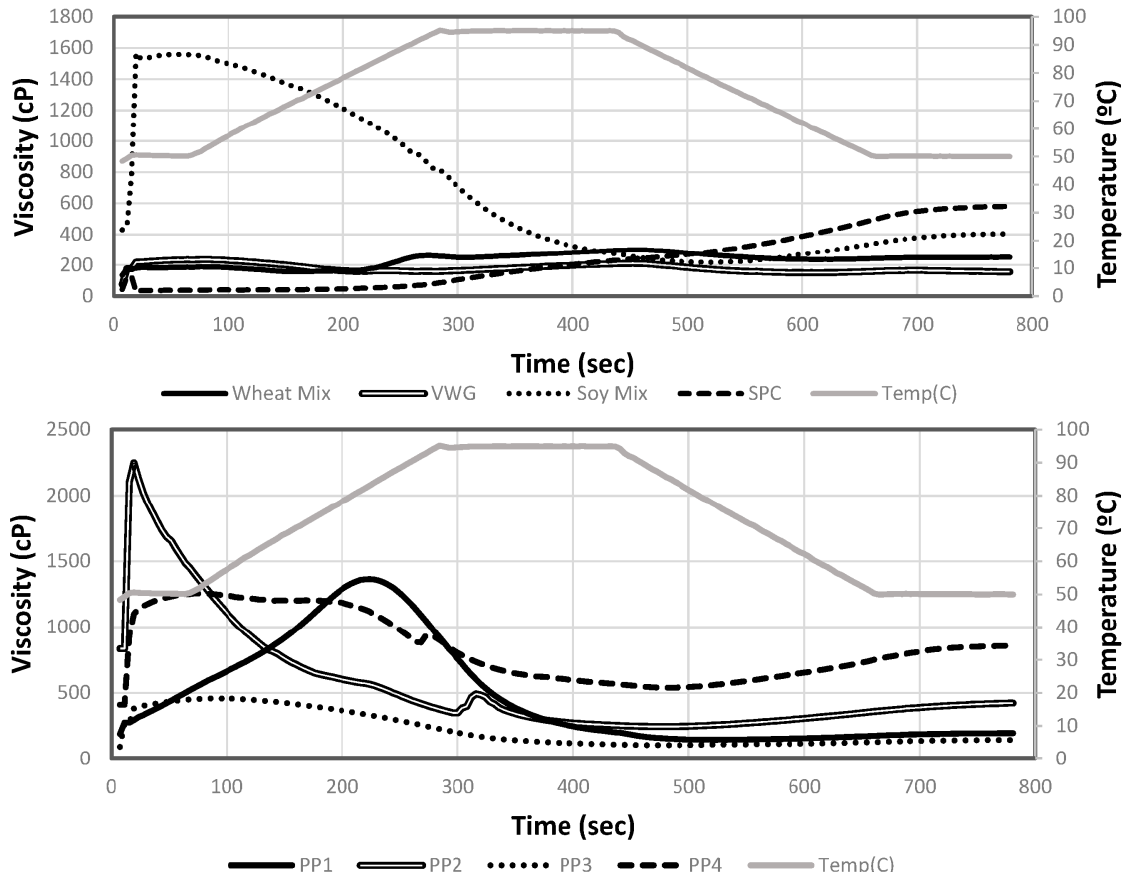
Figure 4. Rapid visco anlayzer (RVA) average viscosity curves for wheat and soy proteins ( top ) and pea proteins ( bottom ) using 15% solids concentration of raw materials.